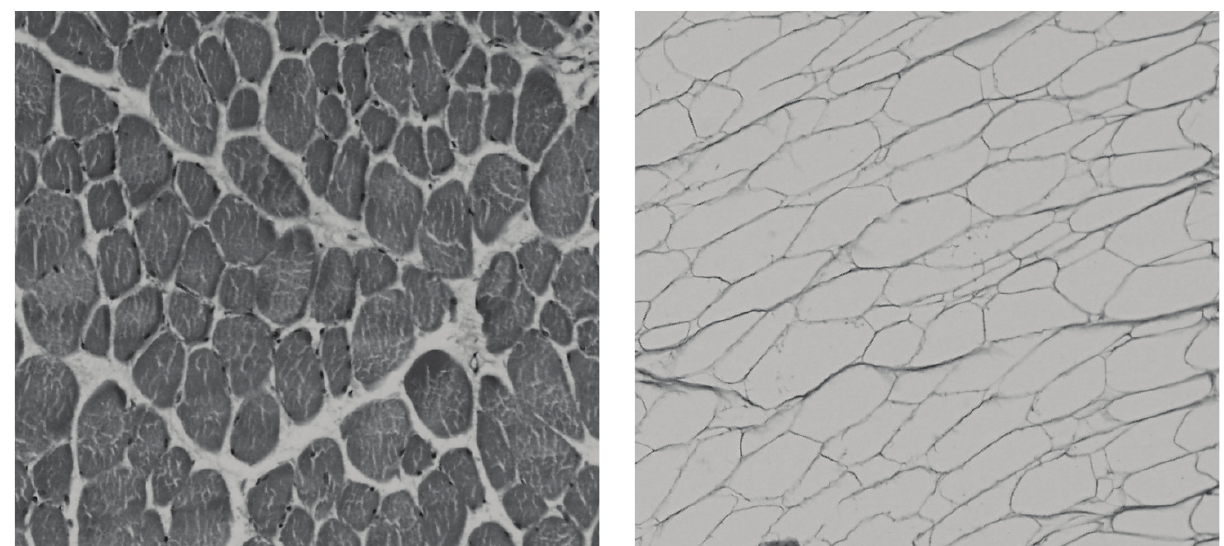
Fig. 1. Comparison between physiological tissue (murine muscle tissue) stained with hematoxyline-eosin and decellularized tissue after 24 h incubation with 1% sodium dodecyl